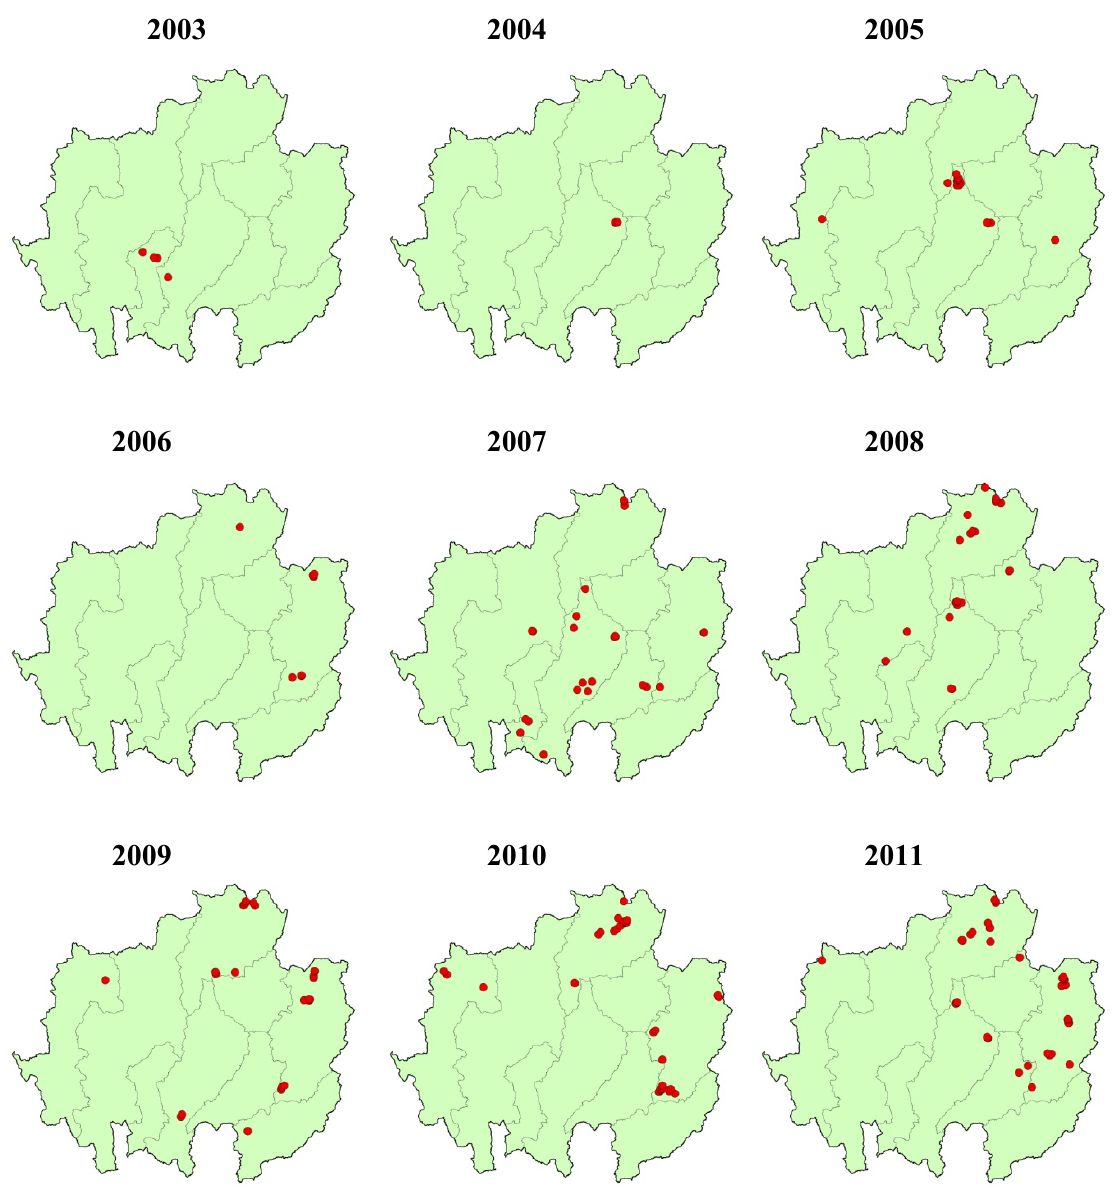
Figure 8. HFMD hotspot development from 2003 to